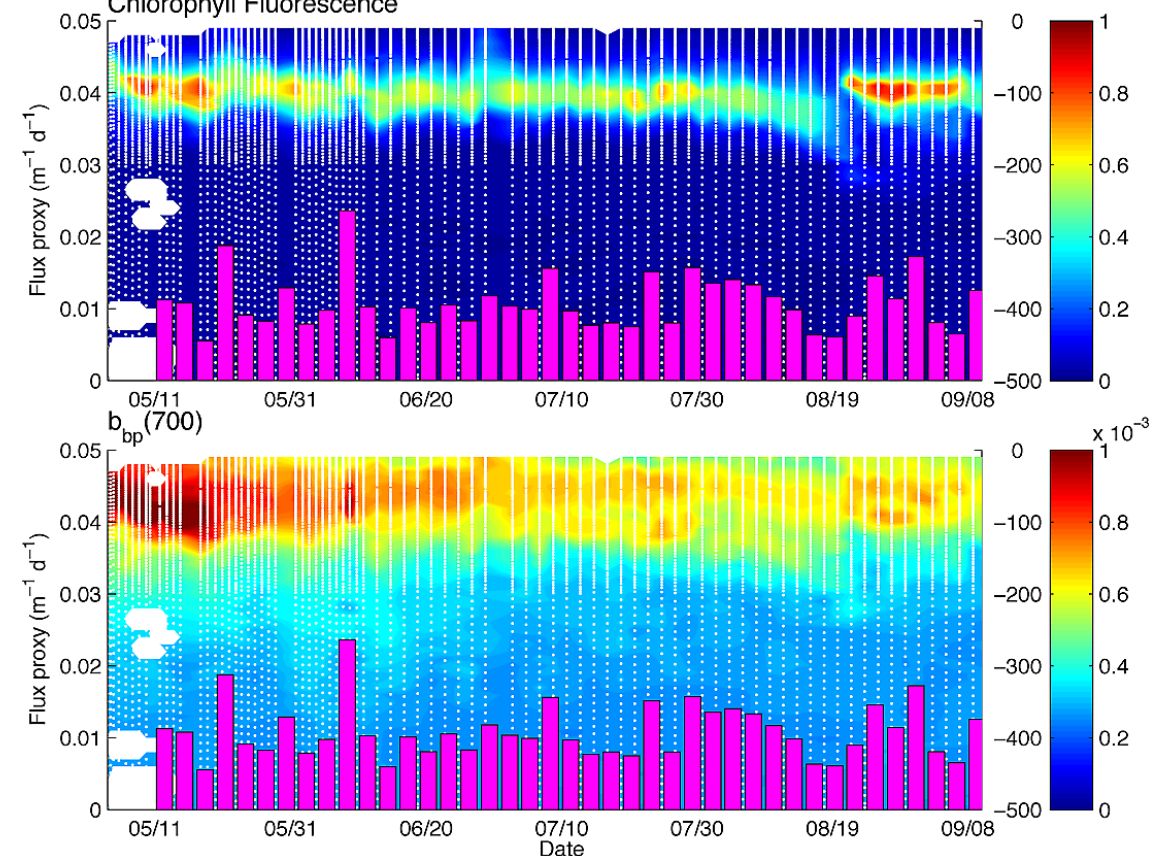
Fig. 9. Upper-water-column ( < 500m) bio-optical data and simultaneous 3-day, bin-averaged, 1000m flux proxy from float SS4. Upper panel: colors show F chl (faint dashed white lines show sample points) and magenta bars show cycle-mean flux proxy. Lower panel: colors show b bp (700); magenta bars are the same as in upper panel. Both panels: left-hand axis denotes flux proxy magnitude, and right-hand axis denotes depth of contoured